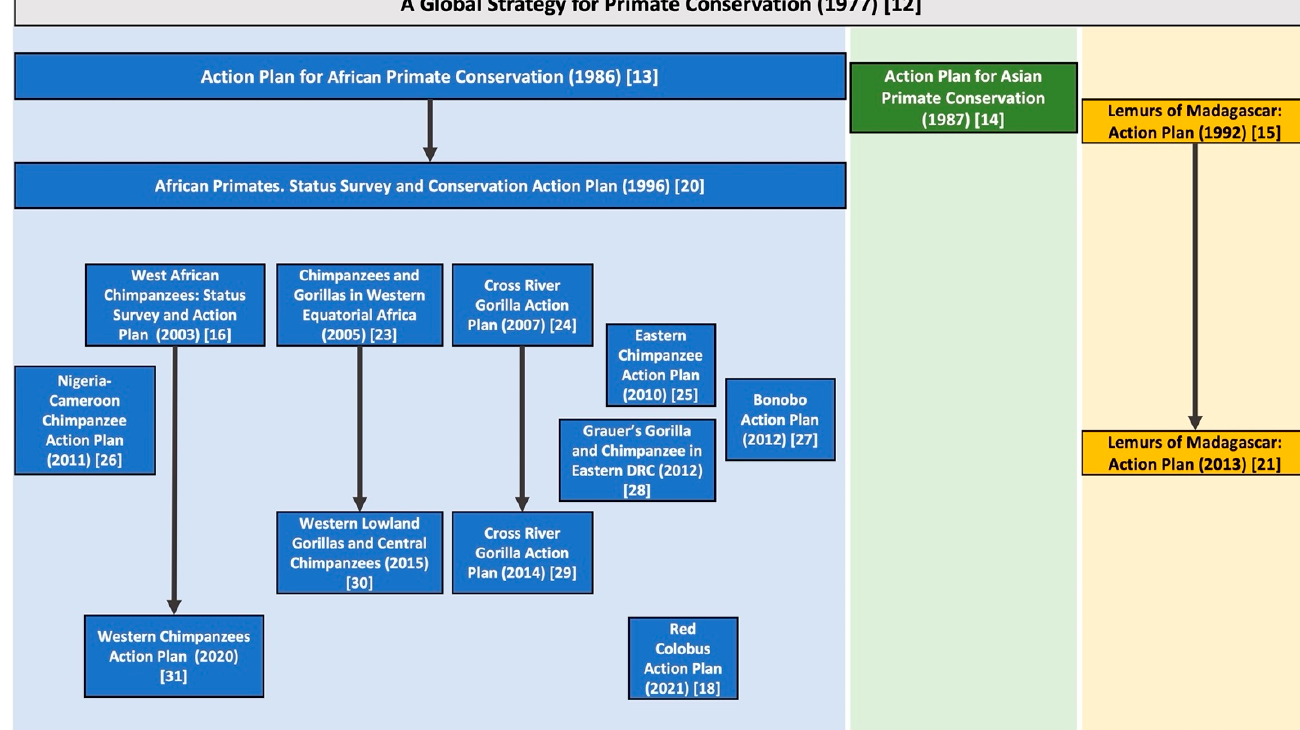
Figure 2. Visualizing the history of IUCN SSC PSG primate conservation action planning from the first global strategy (published in 1977) to the most recently published plan for red colobus. See refs [12–16, 18, 20–21, 23–31].